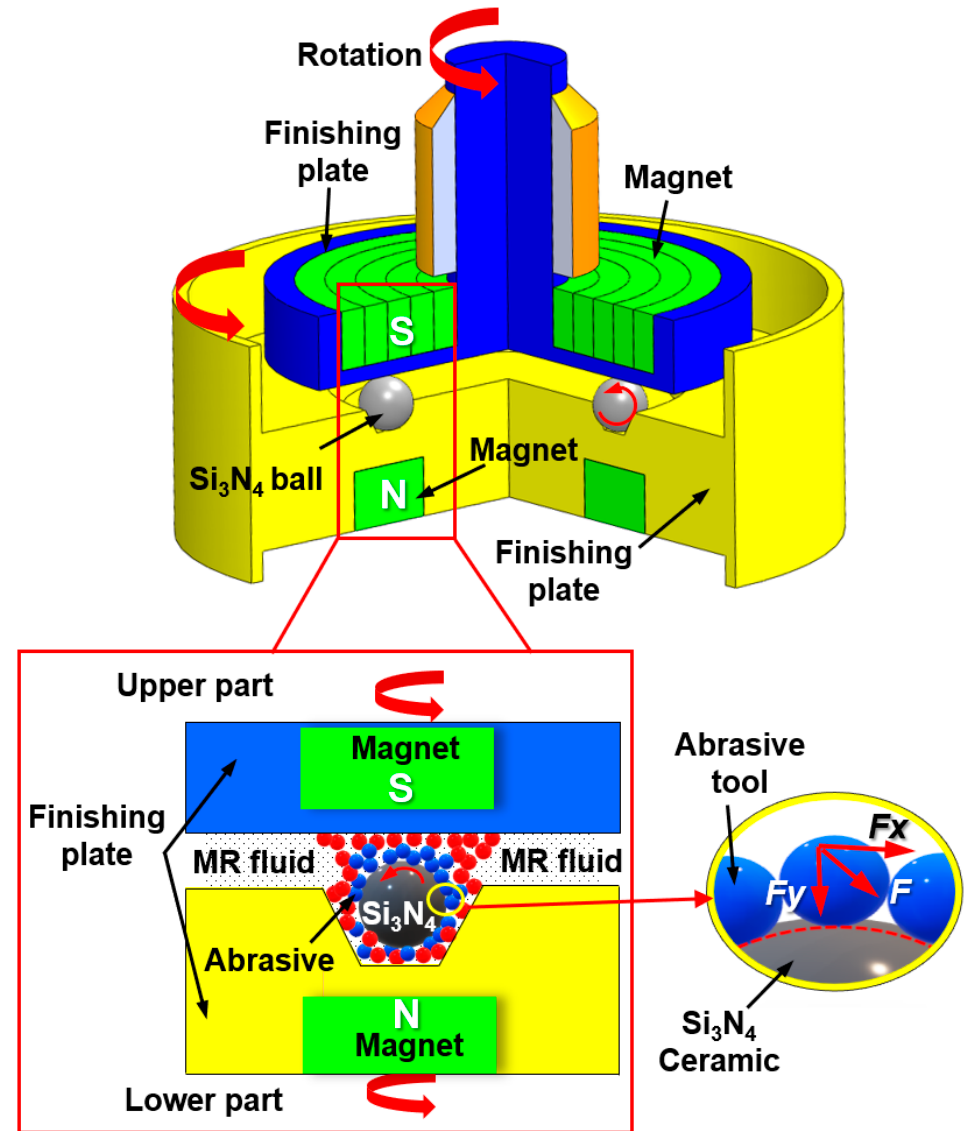
Figure 11. Schematic of the CMRF experiment for the surface finishing of Si 3 N 4 balls, redrawn from [62].